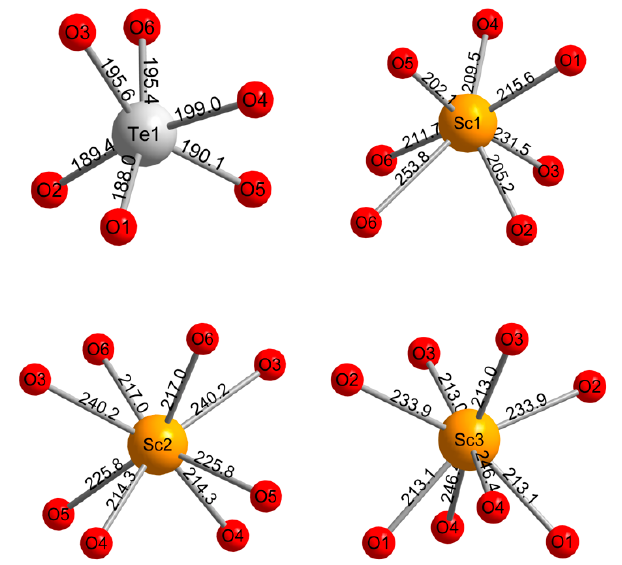
Figure 3. Coordination spheres and interatomic distances (pm) of Te1 (top left), Sc1 (top right), Sc2